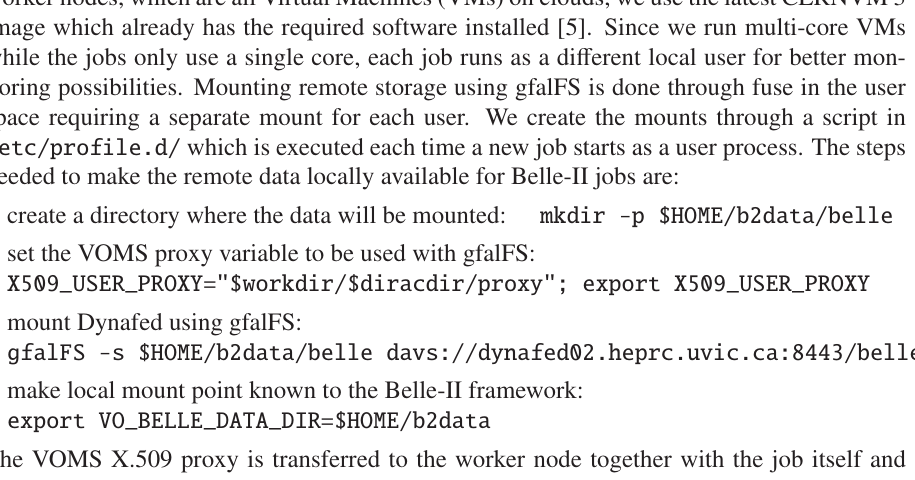
Figure 1: Grid site with distributed compute and Figure 2: Grid site with